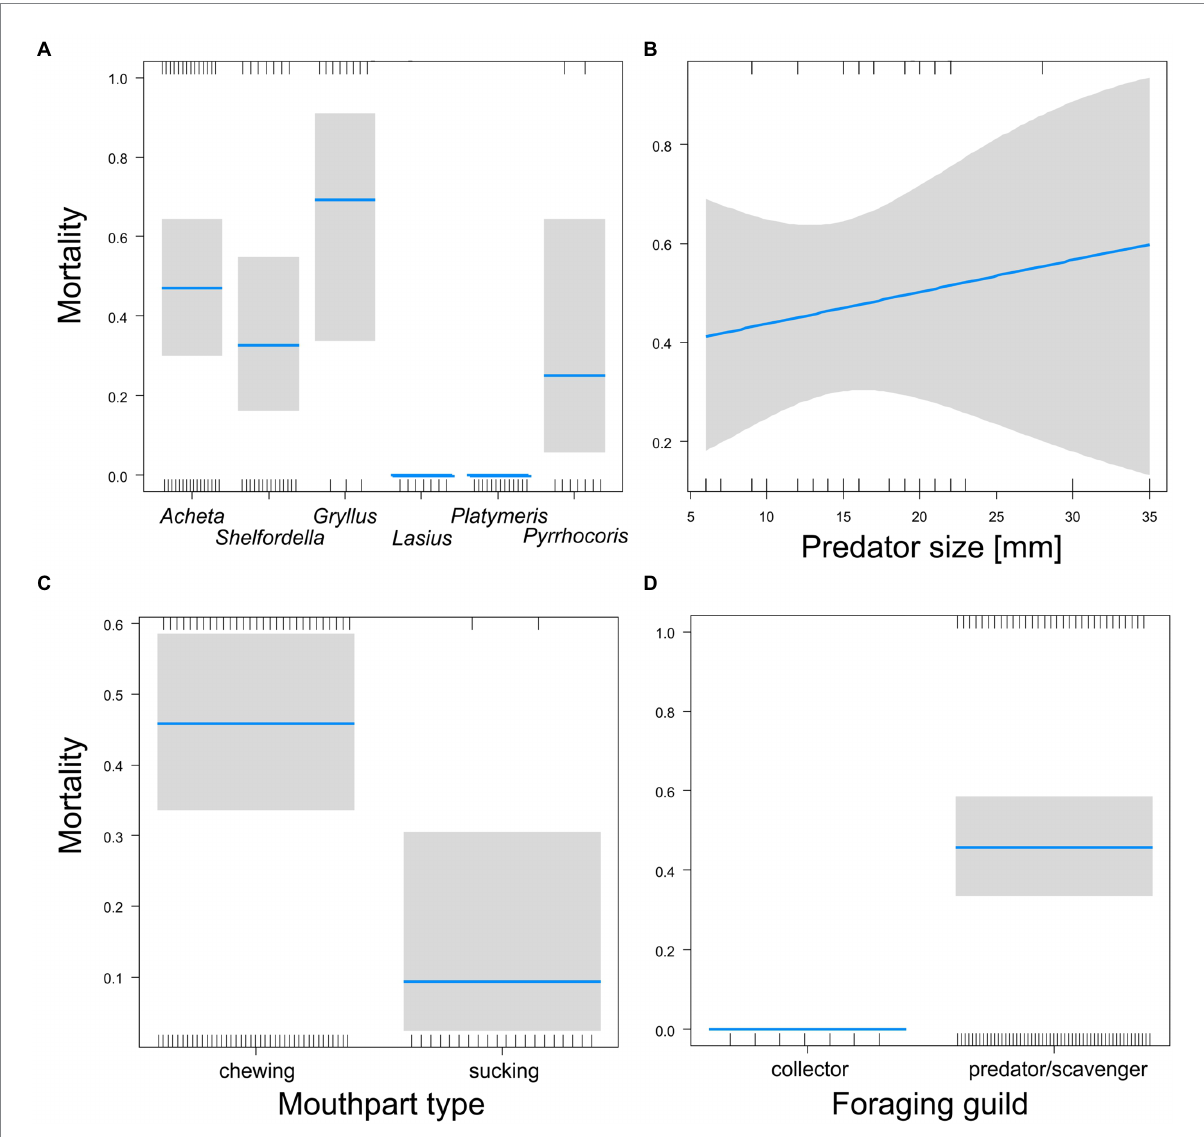
FIGURE 4 Comparison of the mortalities of pupas protected by cocoons caused by six predator species (A) ; the effect of predator size on mortality (B) ; comparison of the effects of two mouth parts (C) and two foraging guilds (D) of predators on pupa mortality. Blue lines (A,C,D) are estimated means, gray bars are 95% confidence intervals of the mean. Blue line (B) is the estimated sigmoid model, gray area is the 95% confidence band of the model. Marks on the horizontal axes represent surviving (upper axis) or dead individuals (lower axis).